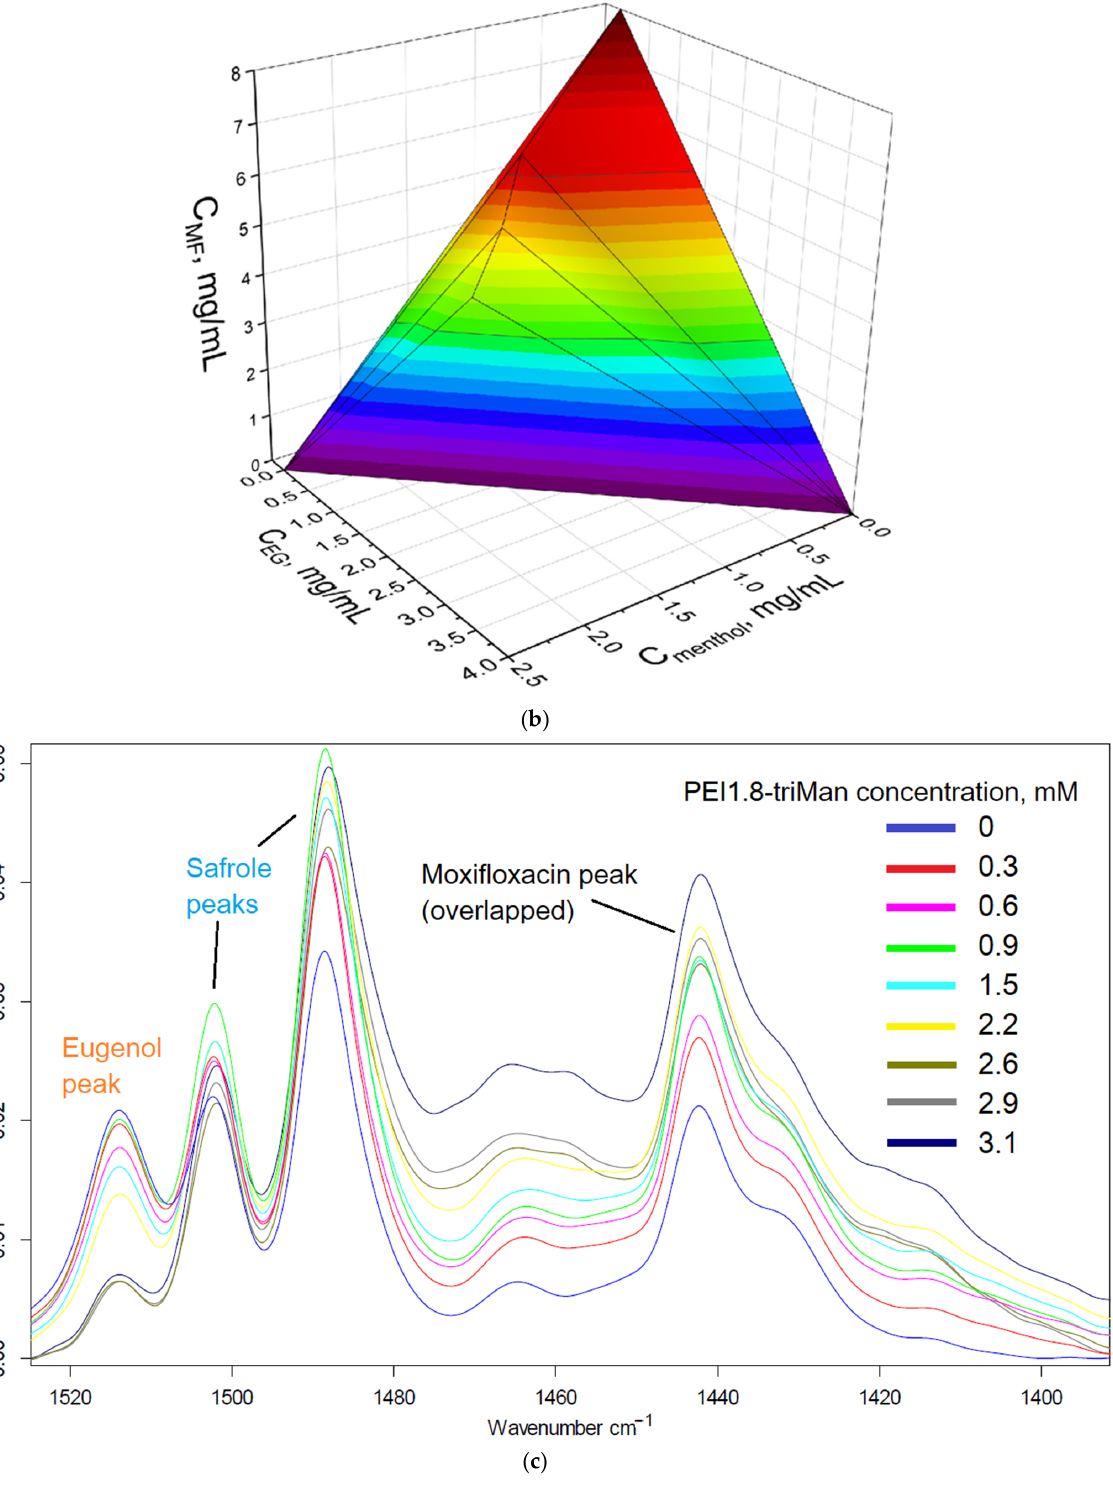
Figure 5. ( a ) Fourier transform infrared spectra of Mannan-amCD complexes with EG, menthol, their mixture and triple formulations MF + EG + menthol with mannan-amCD. The mass ratios are indicated ( w / w ). ( b ) Diagram of the distribution of components in the complex formulation mannan-amCD with MF + EG + menthol. ( c ) Aromatic C–C region in FTIR spectra of four components loaded into a molecular container at once: moxifloxacin 0.9 mM, eugenol 17 mM, safrole 12 mM and menthol 12 mM. T = 22 ◦ C. Phosphate buffer solution (0.02 M, pH 6.4). T = 22 ◦ C. Ligand spectra were subtracted as